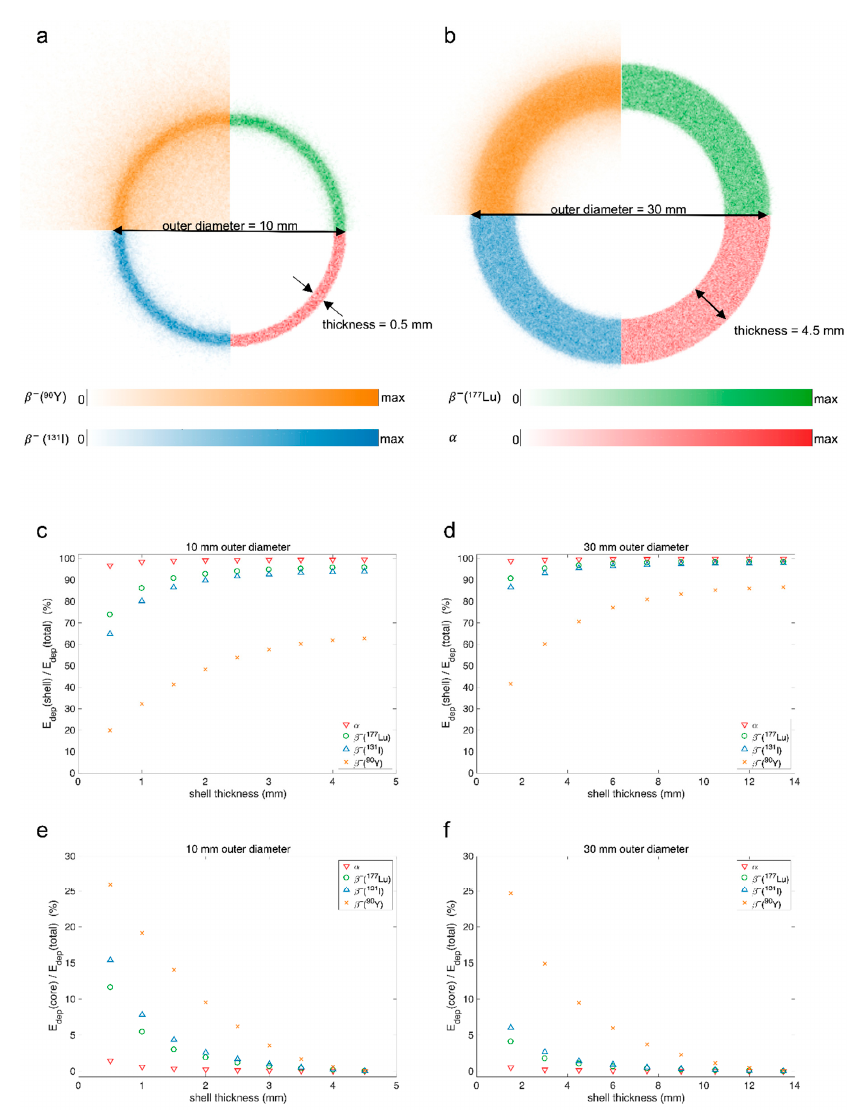
Figure 4. The figure shows energy deposited in and around a spherical shell source. This approxi- mates a situation where there is uptake around the outer rim of a core without uptake. Panels ( a , b ) illustrate examples of shell thicknesses for the two outer diameters and show the central slices of images containing the energy deposition maps of the shells, where each quarter shows a different source. In panels ( c , d ), the ratio of energy deposited in the shell source (E dep (shell)) to total deposited energy (E dep (total)) is plotted against the shell thickness. In panels ( e , f ), the ratio of energy deposited in the core (E dep (core)) to total deposited energy is also plotted against shell thickness. Two different outer diameters were used: in ( a , c , e ), shells with an outer diameter of 10 mm are shown, and, in ( b , d , f ), shells with an outer diameter of 30 mm are shown. Four different sources were used, three pure beta sources with beta energies following the emission spectra for 90 Y, 177 Lu, and 131 I, and an alpha source with alpha energies of 5.5